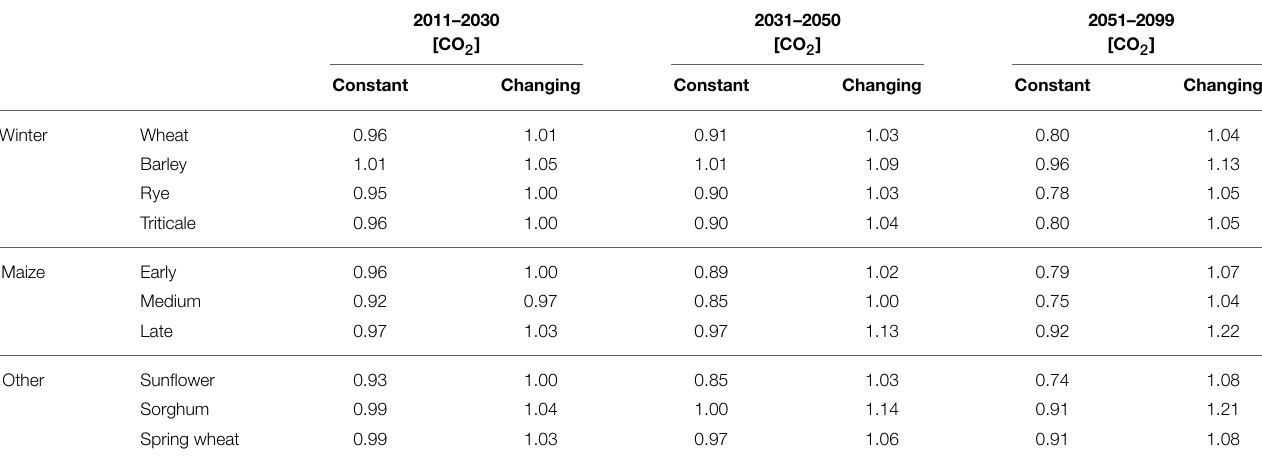
TABLE 3 | Quotient of crop biomass of specified periods in relation to 2001–2010 ( =